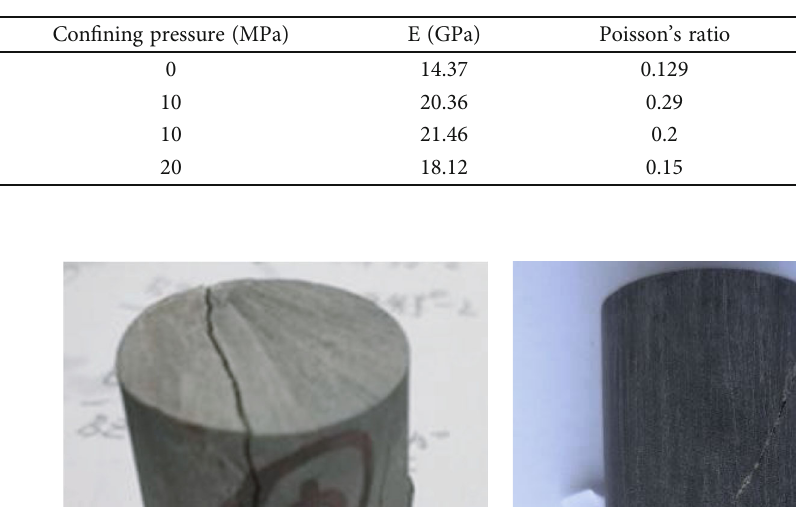
Table 3: Rock mechanical testing results.